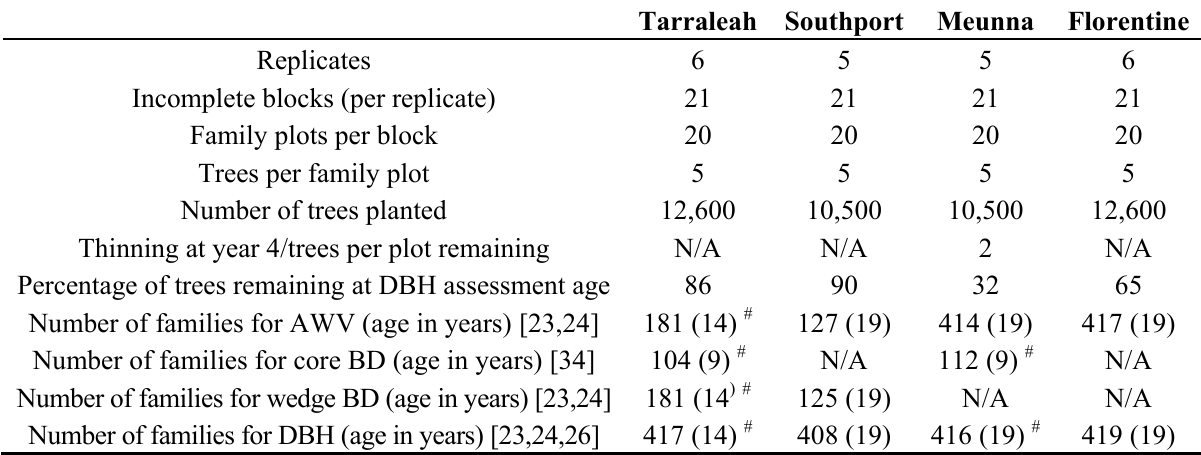
Table 2. Design, family and survival details of the four Eucalyptus nitens progeny trials assessed for acoustic wave velocity (AWV), basic density (BD) and diameter at breast height (DBH; 1.3 m). Published studies that contributed trait data to this study are indicated. Tarraleah Southport Meunna Florentine Replicates 6 5 5 6 Incomplete blocks (per replicate) 21 21 21 21 Family plots per block 20 20 20 20 Trees per family plot 5 5 5 5 Number of trees planted 12,600 10,500 10,500 12,600 Thinning at year 4/trees per plot remaining N/A N/A 2 N/A Percentage of trees remaining at DBH assessment age 86 90 32 65 Number of families for AWV (age in years) [23,24] 181 (14) # 127 (19) 414 (19) 417 (19) Number of families for core BD (age in years) [34] 104 (9) # N/A 112 (9) # N/A Number of families for wedge BD (age in years) [23,24] 181 (14 ) # 125 (19) N/A N/A Number of families for DBH (age in years) [23,24,26] 417 (14) # 408 (19) 416 (19) # 419 (19) # trait data previously